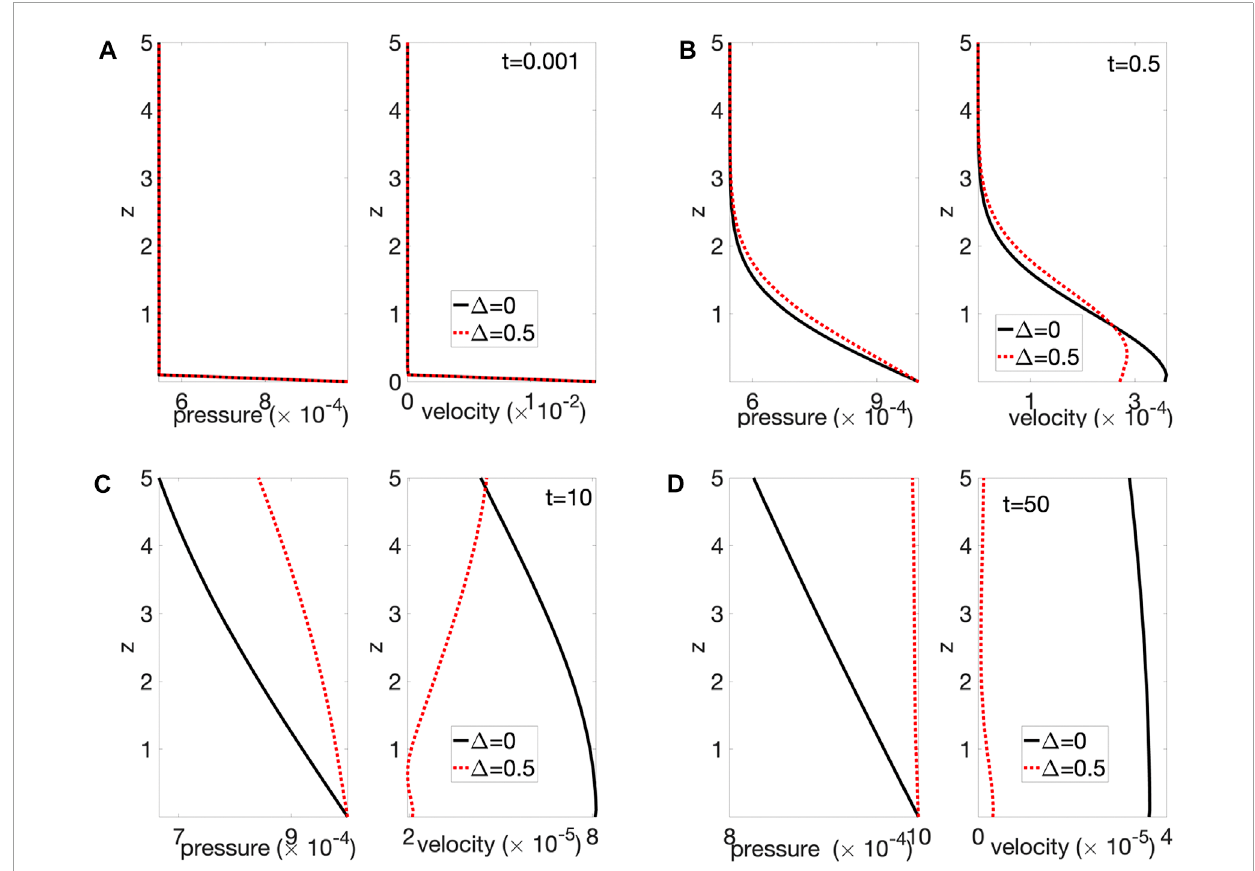
FIGURE 8 Distribution of pore pressure and melt velocity along the mush column at (A) t = 0 . 001, (B) t = 0 . 5, (C) t = 10, and (D) t = 50. In each sub-figure, left panel shows to pressure profile, right panel shows melt velocity profile. At time t = 0, the mush column is subjected to a step rise in fluid pressure at the source z = 0. Black solid lines correspond to a poroelastic mush column with Δ = 0; red dash lines corresdpond to a thermo-poro-elastic mush with Δ = 0 . 5. With the proceeding of time, pressure increases faster for the case with Δ = 0 . 5, resulting in reduction in pressure gradient and decrease of fluid velocity. Other parameters used for (B) include melt bulk modulus K l = 1 GPa, shear modulus μ = 1 GPa, solid bulk modulus K s = 10 GPa, porosity ϕ = 0 . 3, and gas volume fraction in pore melt χ =